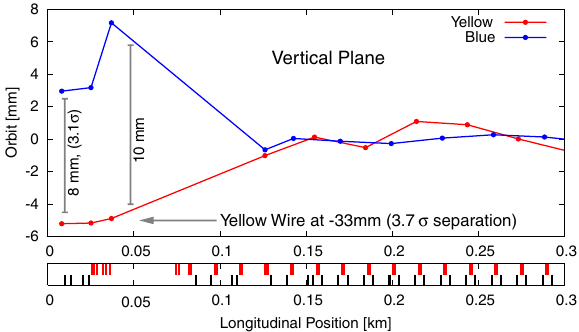
FIG. 17. Single bunch intensities as a function of wire position for Blue (top) and Yellow (bottom) rings with a current of 50 A. Comparison between bunches with head-on and no head-on collision is shown.